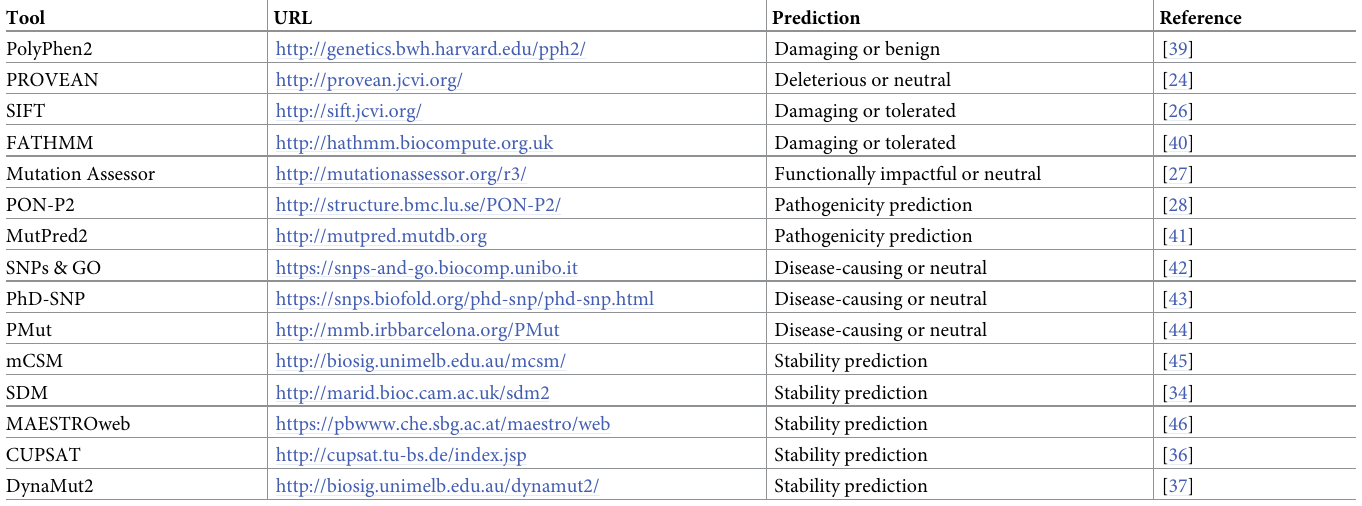
Table 1. Tools for the analysis of single amino acid substitutions. Tool